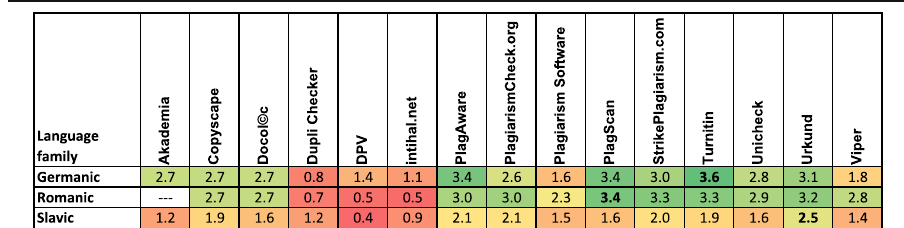
Table 3 Coverage results according to the language